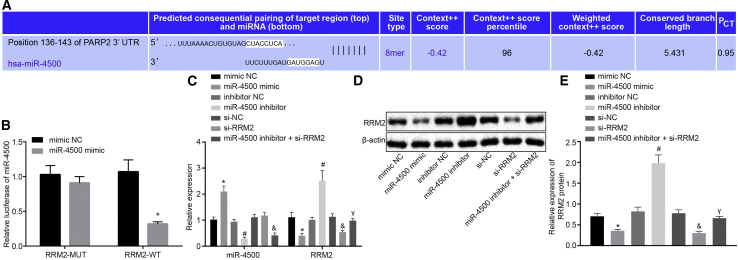
RRM2 Is a Target Gene of miR-4500(A) The predicted binding sites of miR-4500 and RRM2 3′ UTR. (B) The dual luciferase reporter gene assay for detecting luciferase activity. (C) The expressions of miR-4500 and RRM2 detected by qRT-PCR. (D) The electrophoresis strip of RRM2 protein detected by western blot analysis. (E) The expressions of RRM2 protein detected by western blot analysis. ∗, #, &, and γp < 0.05 versus the mimic NC group, inhibitor NC group, si-NC group, and miR-4500 inhibitor group, respectively. (B) The data comparison was analyzed by unpaired t test, and (C and E) the data were analyzed by one-way ANOVA. The experiment was repeated three times independently.